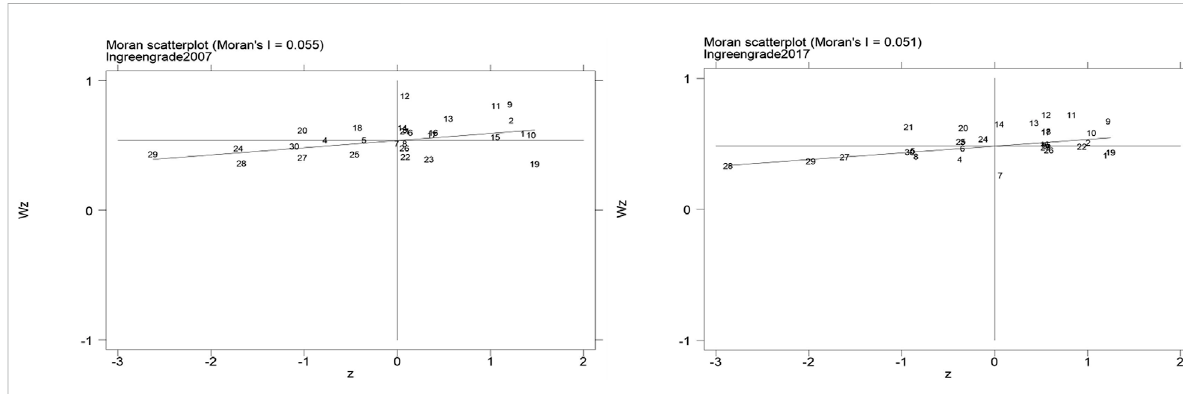
FIGURE 4 Moran ’ s I index scatter of industrial green transformation in 2007 and 2017.